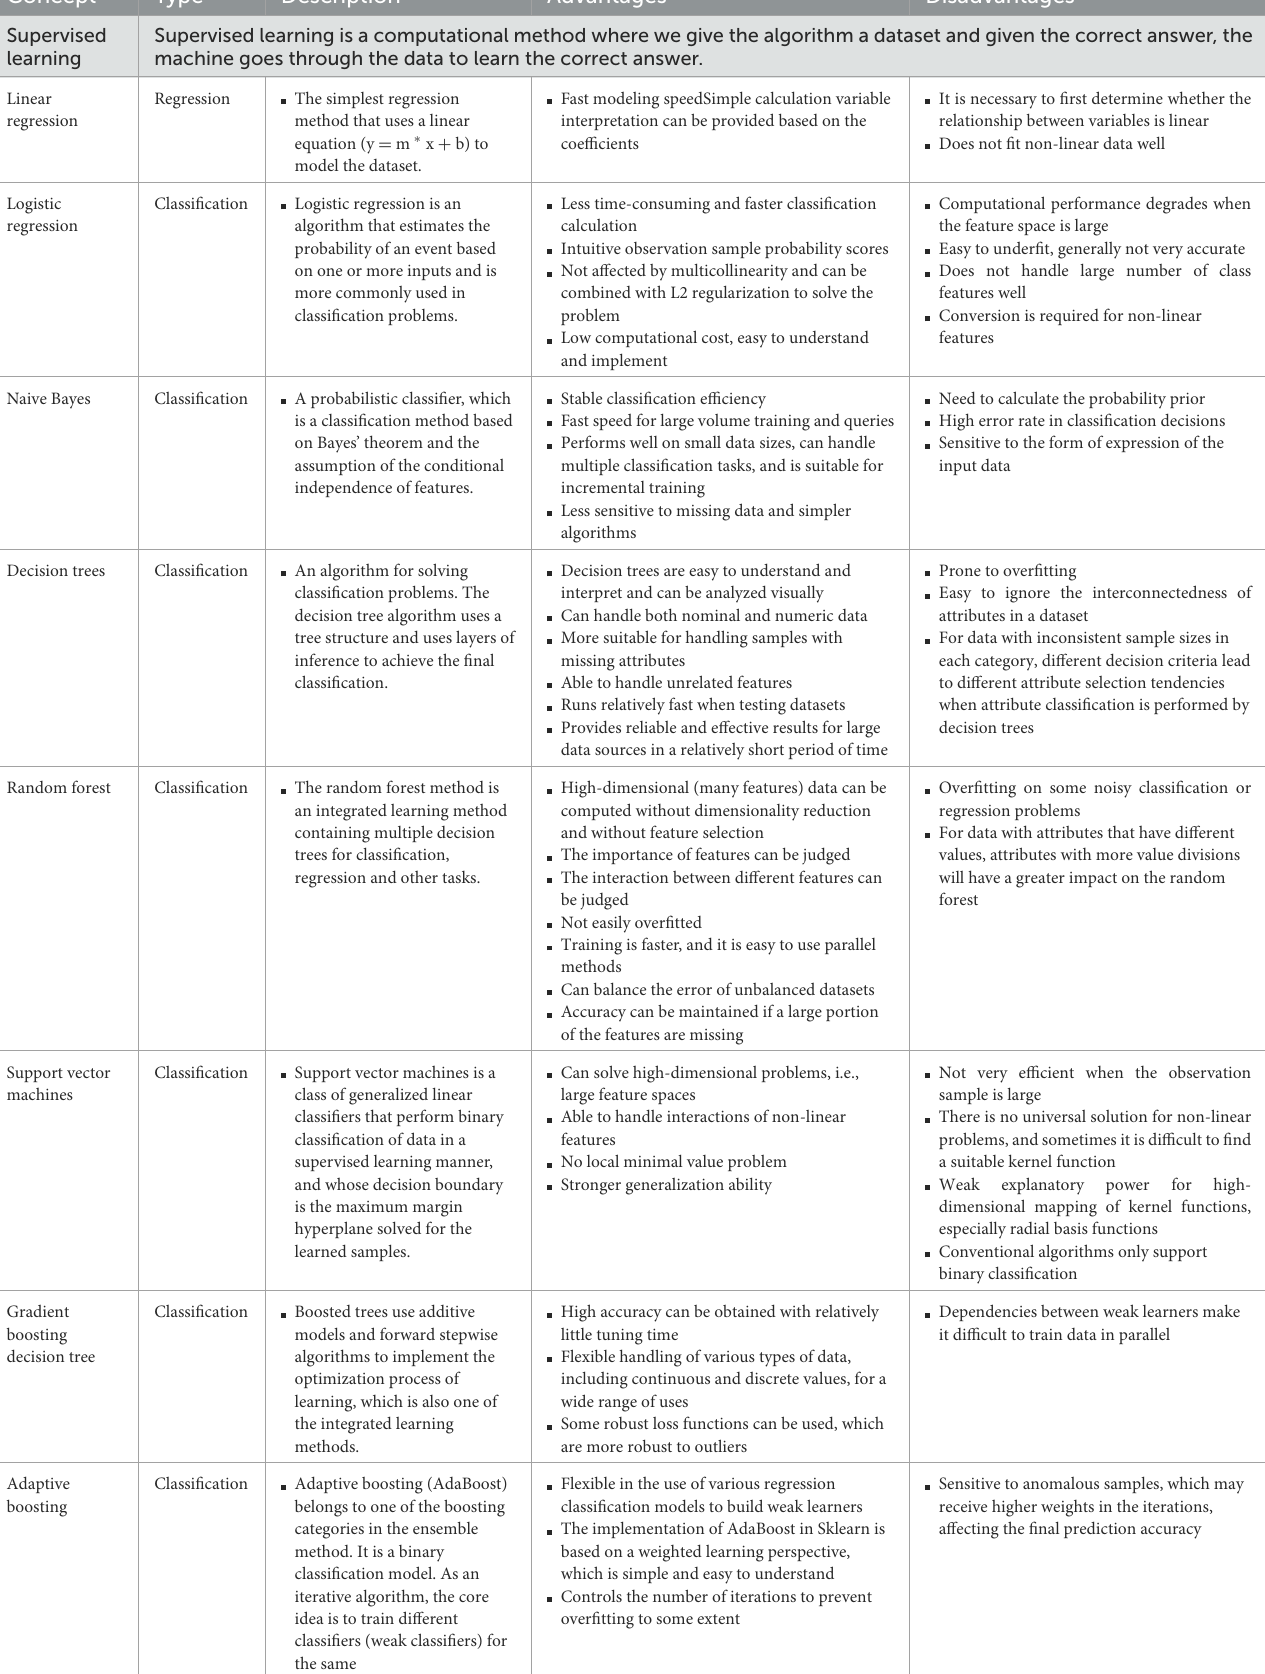
TABLE 1 Description of machine learning